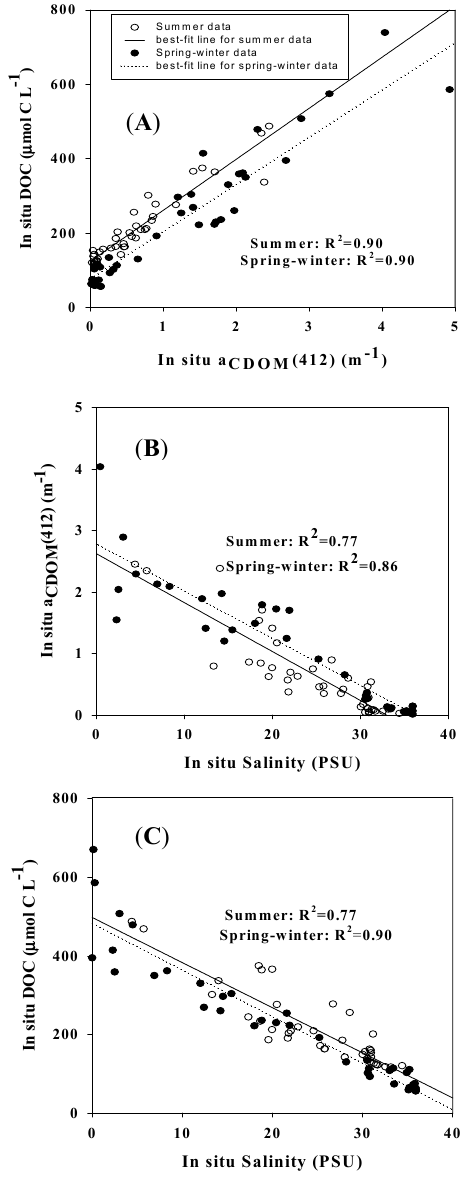
Figure 2. Relationship between ( A ) in situ a (412) and in situ DOC in spring-winter CDOM and in summer; ( B ) in situ a (412) and in situ salinity in spring-winter and in summer; CDOM ( C ) in situ DOC and in situ salinity in spring-winter and in